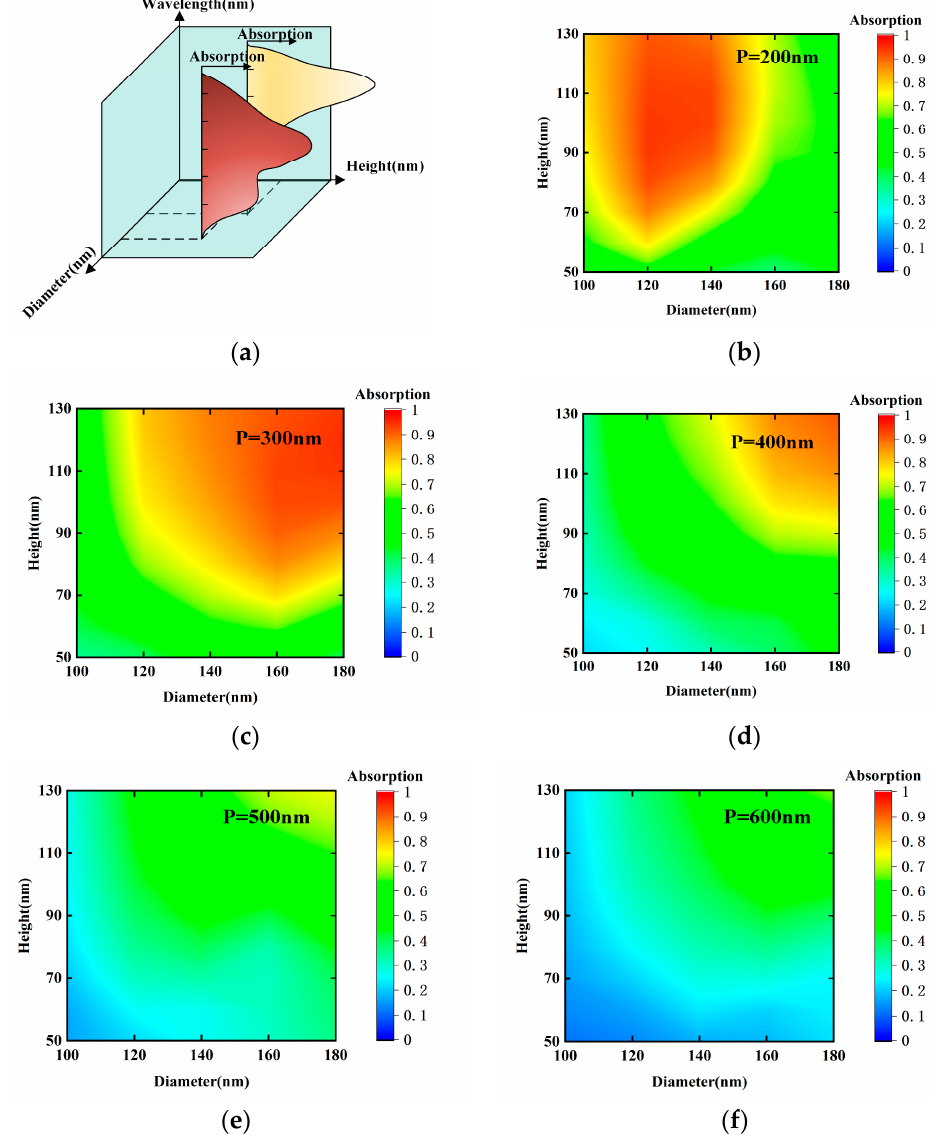
Figure 4. ( a ) Schematic diagram of the three-dimensional relationship between absorption and ra- dius, height, and wavelength. Si under the period of ( b ) 0.2 μ m, ( c ) 0.3 μ m, ( d ) 0.4 μ m, ( e ) 0.5 μ m, height, and wavelength. Si under the period of ( b ) 0.2 µ m, ( c ) 0.3 µ m, ( d ) 0.4 µ m, ( e ) 0.5 µ m, and and ( f ) 0.6 μ m. Height ranges from 0.05 μ m to 0.13 μ m with a step size of 0.02 μ m. The radius factor ( f ) 0.6 µ m. Height ranges from 0.05 µ m to 0.13 µ m with a step size of 0.02 µ m. The radius factor ranges from 0.05 μ m to 0.09 μ m with a step size of 0.01 μ m. ranges from 0.05 µ m to 0.09 µ m with a step size of 0.01 µ m.